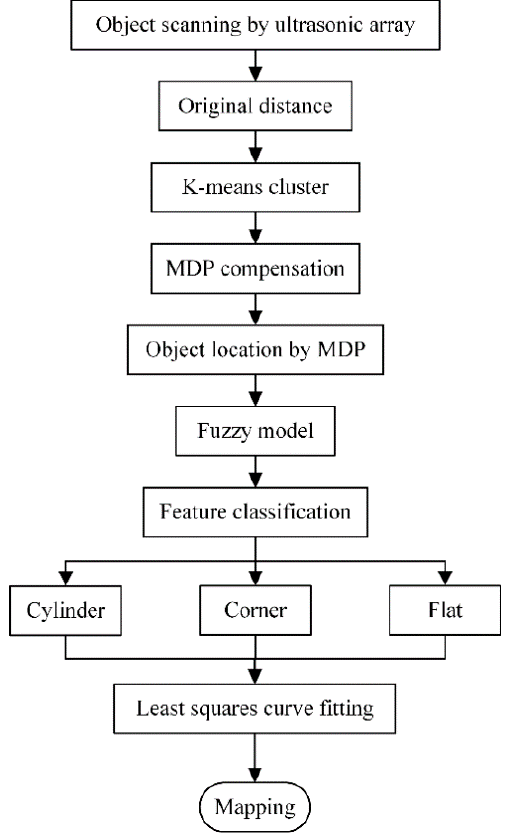
Figure 9. Flowchart of feature extraction, classification, and mapping.